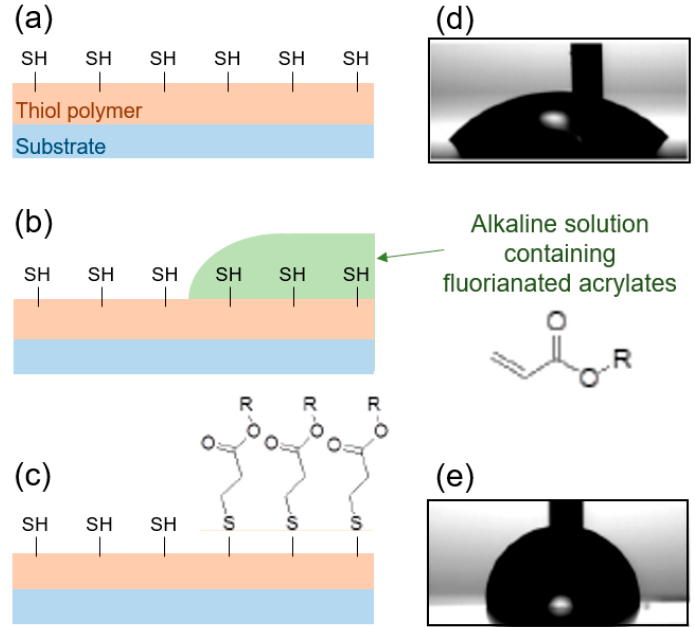
Figure 5. Surface chemistry on the polymer using the thiol functional groups. An imprinted thiol polymer sample ( a ), which has surface-active thiol groups, is incubated with a solution of fluorinated acrylate and trimethylamine ( b ) for 24 h. The molecules selectively react with the thiol functional groups in a Michael addition ( c ). The contact angle of the untreated sample is 40° ( d ), while after the chemical surface modification, it increases to 77° ( e ).